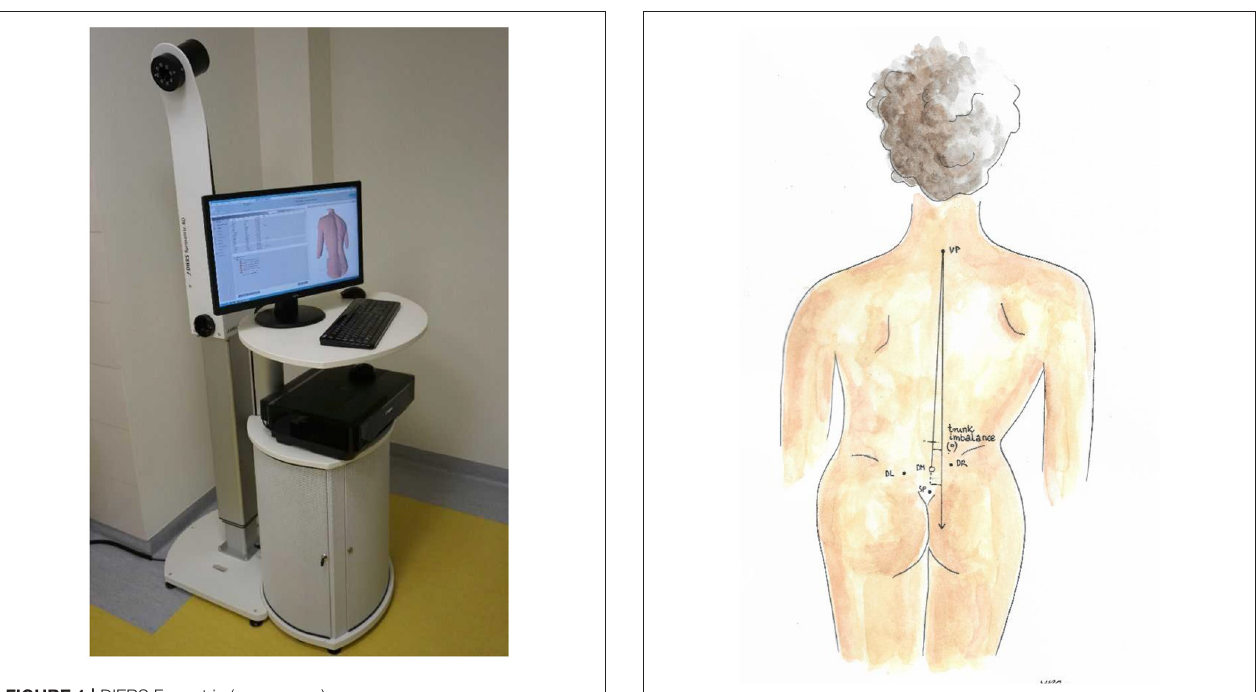
FIGURE 3 | Trunk imbalance VP –